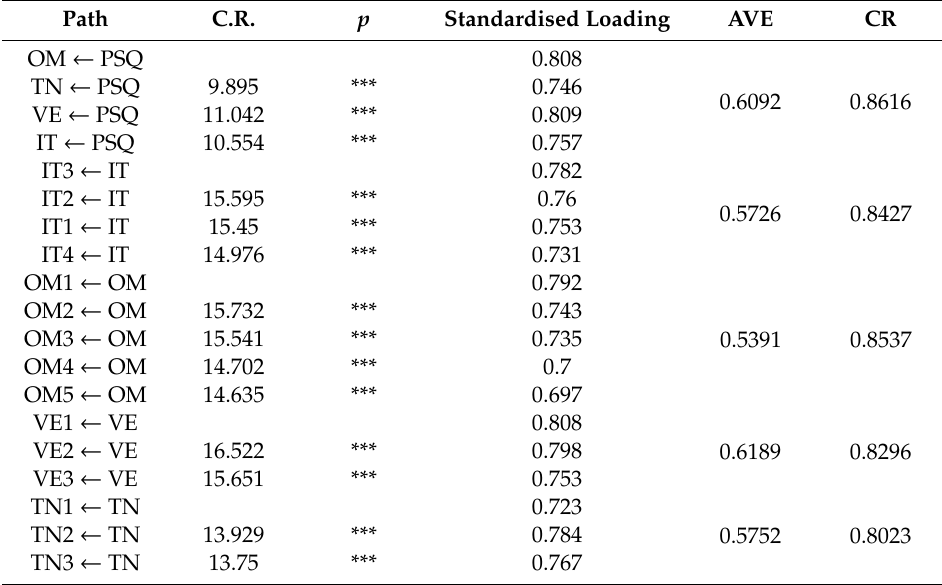
Table 3. Parameters of confirmatory factor analysis (CFA). C.R., critical ratio; AVE, average variance extracted; CR, composite reliability.